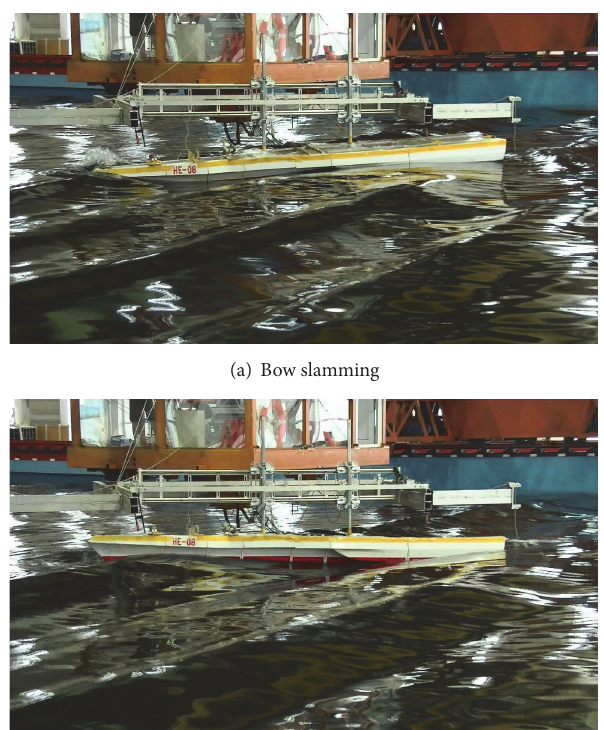
Figure 39: Bow slamming in bow